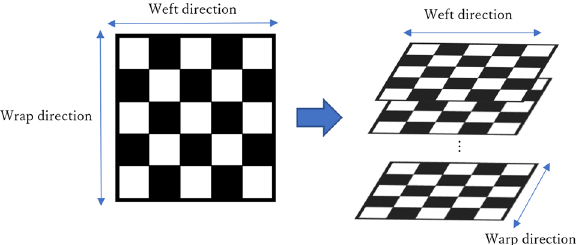
Figure 3. Laminated configuration of woven fabric using spreading.